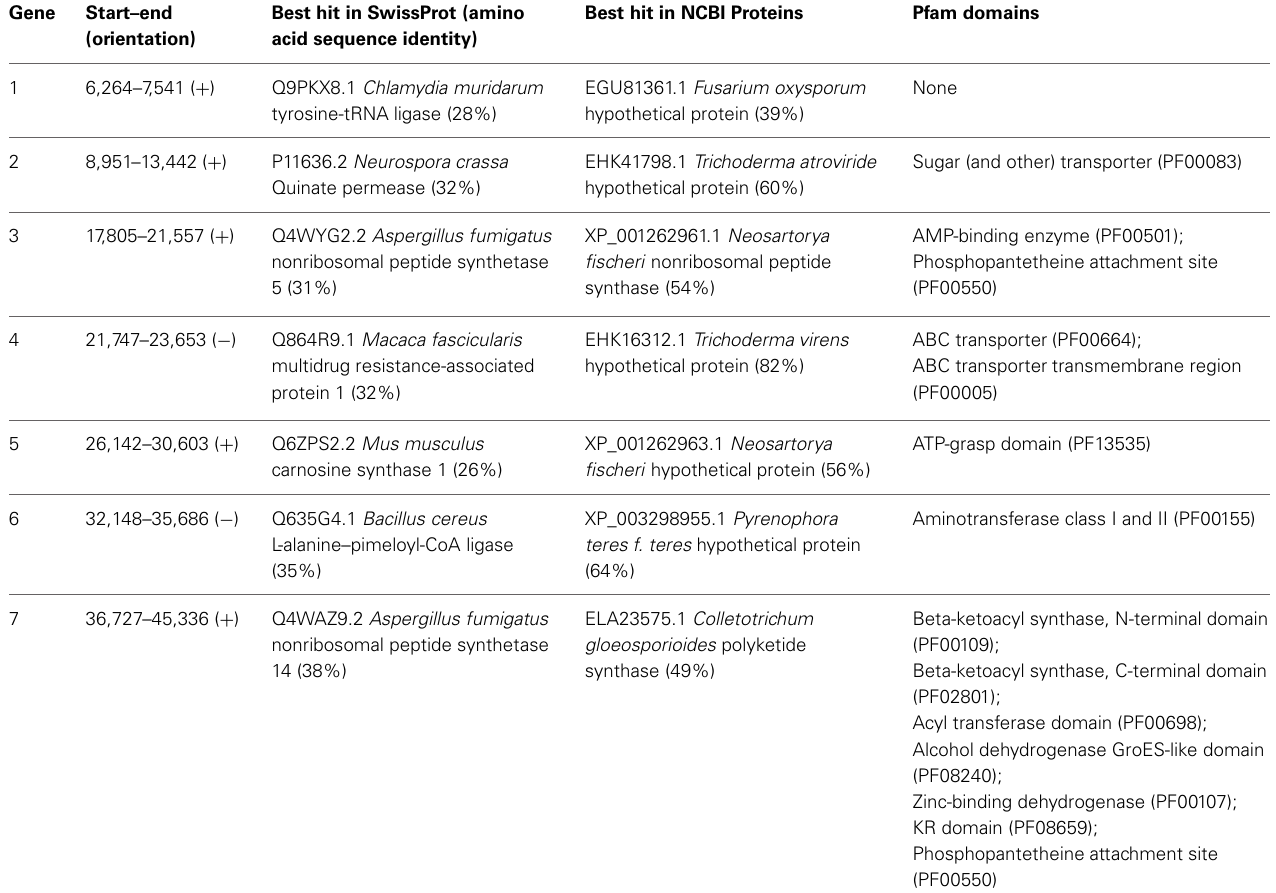
Table 1 | Genes encoded in a 47-kbp genomic region unique to Trichoderma hamatum